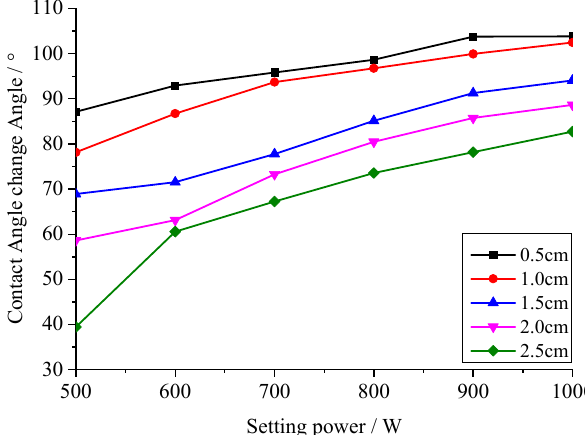
Figure 25. Contact angle curve of the mobile phone cover. Table 6. Data sheet of glass and aluminum materials for plasma cleaning. Setting Power (W)